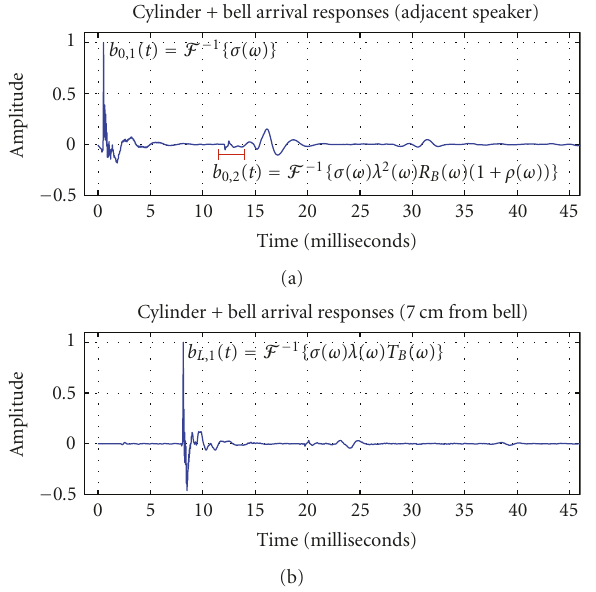
Figure 9: Arrival responses of the cylinder and bell at speaker (a) and outside the bell (b). Notice the low-amplitude e ff ects of the junction reflection just before the higher-amplitude bell reflection in the second arrival ((a), underlined at approximately 12–14 milliseconds).